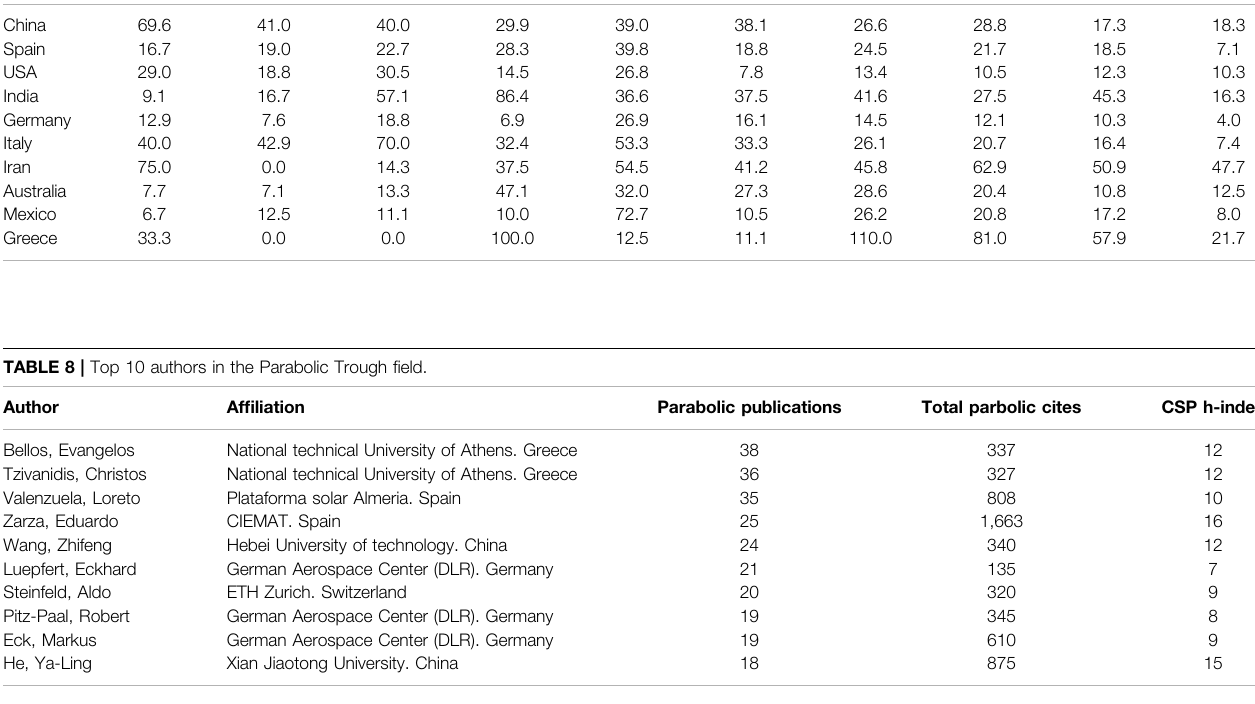
TABLE 7 | Country increment of the parabolic trough fi eld publications compared to the accumulated ones from the previous year. Country